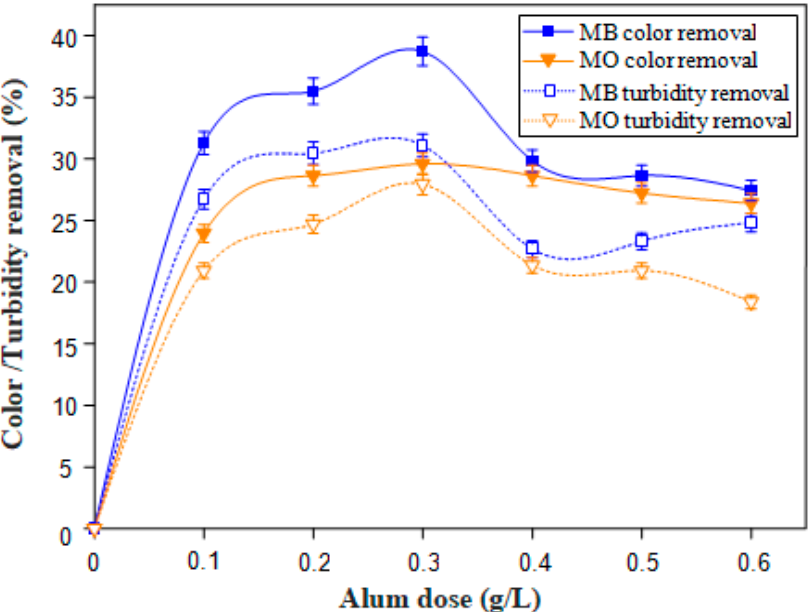
Figure 3. Color and turbidity removal for MB and MO solutions (C = 0.10 g/L) using only alum as